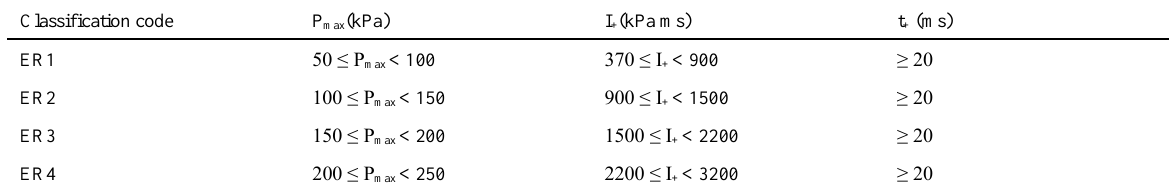
Table 1 : Classification of explosion pressure resistance glazing according to EN